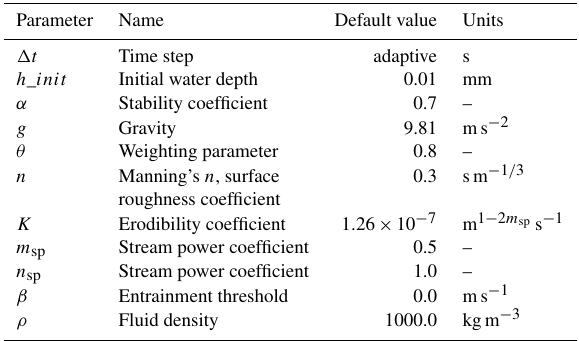
Figure 5. In the de Almeida et al. (2012) equation, flux information from neighboring links is used to calculate surface water discharge. In this sample one-dimensional grid, discharge is calculated in the horizontal (subscript x ) direction on links. Here, discharge is calculated at location q x using the left neighbor ( q x 1 ) and right neighbor ( q x 1 ) flux values, following Eq. (4). − + Table 2. List of parameters used in the OverlandFlow and Detach- mentLtdErosion. For each variable, the name and units are